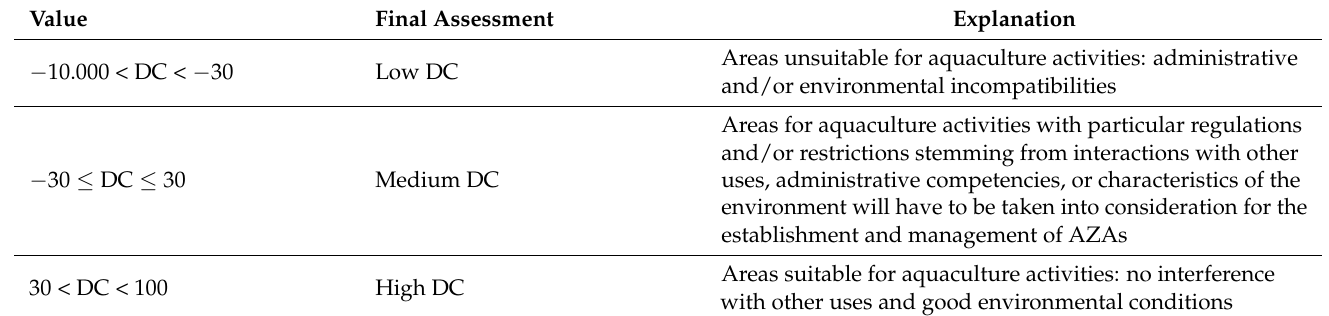
Table 7. Degree of compatibility for assigning an AZA (adapted from